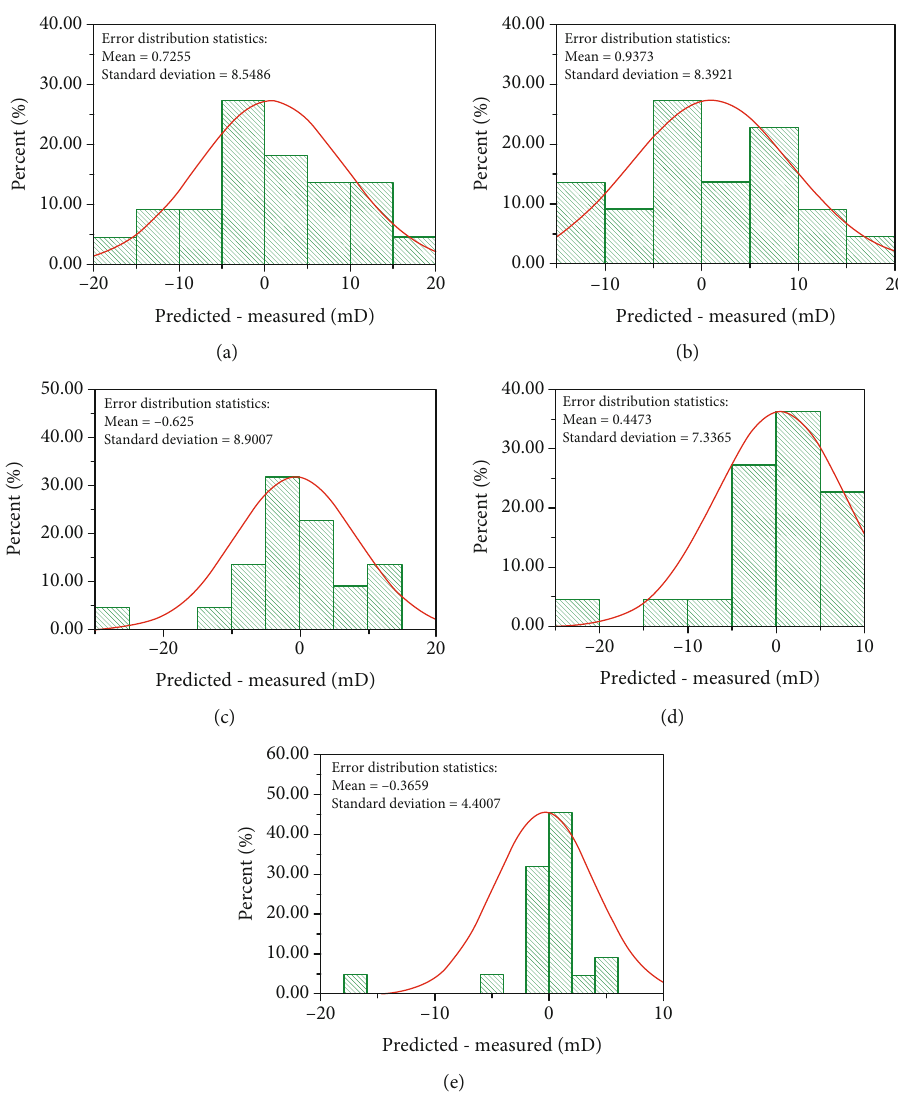
Figure 9: Error distribution statistics for all models proposed in this study aimed at predicting the permeability. Low values of the mean standard deviation (STD) indicate the exceptional performance of the SVR model: (a) Swanson parameter-based model, (b) improved Swanson parameter-based model, (c) capillary parachor parameter-based model, (d) improved capillary parachor parameter model, and (e) SVR-based